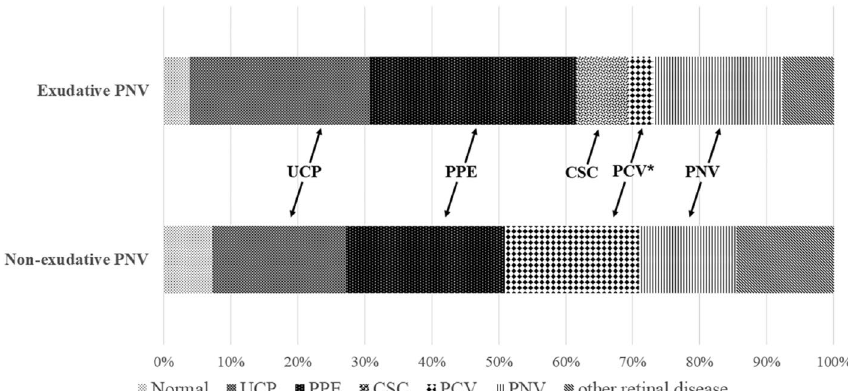
Figure 3. Distribution of the diagnosis in the fellow eyes. The only diagnosis with significant differences between the two groups was PCV (asterisk (*), 3.8% vs. 20.0%, P < 0.027, Fisher’s exact test). UCP, uncomplicated pachychoroid; PPE, pachychoroid pigment epitheliopathy; CSC, central serous chorioretinopathy; PCV, polypoidal choroidal vasculopathy; PNV, pachychoroid